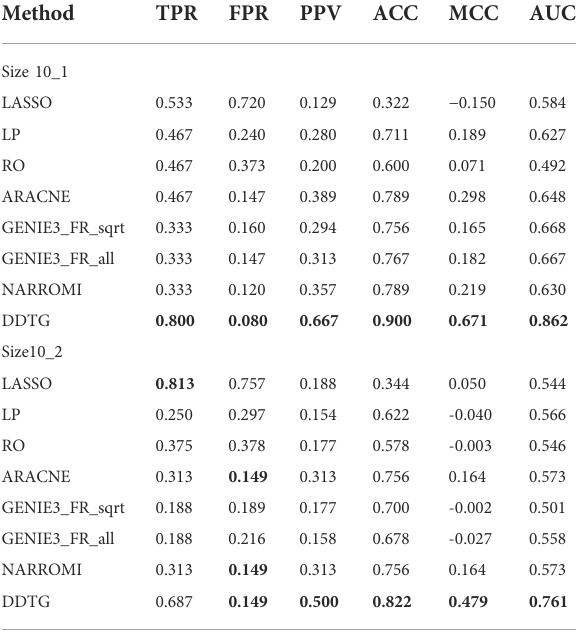
TABLE 2 Comparison on networks from DREAM4 datasets with size